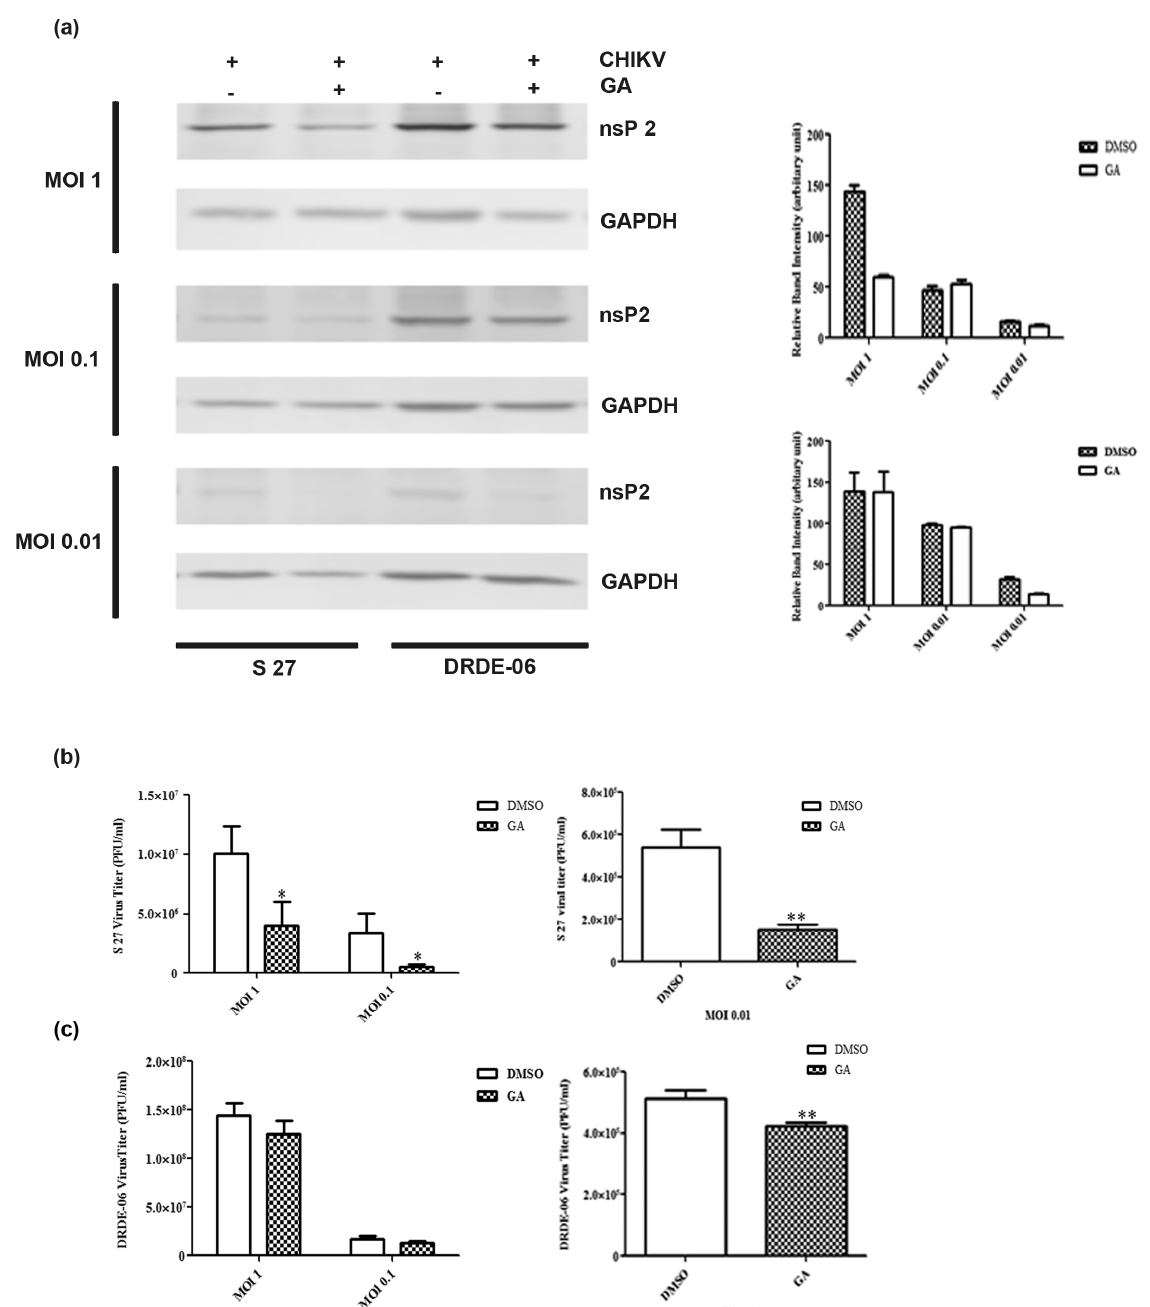
Figure 3. Effect of GA on virus replication with different MOIs of CHIKV. Vero cells were infected with different MOIs (1, 0.1, 0.01) of either S 27 or DRDE-06 virus and treated with 50 m M concentration of GA. (a) The cells were harvested at 8 hpi, lysed and Western blot analysis was performed by probing with nsP2 monoclonal antibody. GAPDH served as the loading control. The reduction in nsP2 level was quantified and the relative band intensity is shown as bar diagram in the right panel (n=3, p , 0.05) (b) and (c) The supernatants were collected at 8 hpi and infective progeny virus particle titre was determined by Plaque assay. Data of three independent experiments are represented as mean 6 SD (* p , 0.05).